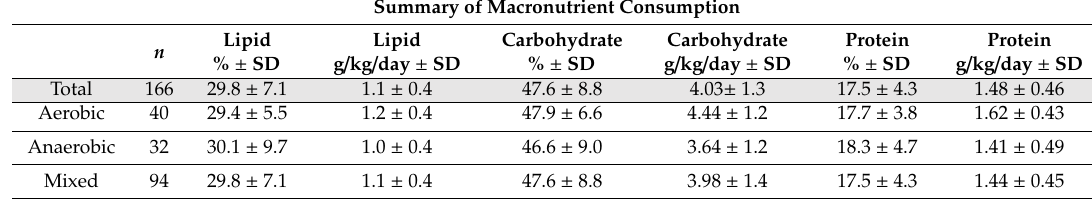
Table 2. Summary of daily macronutrient caloric contribution according to sport type. Macronutrient intake (excluding supplement) is presented both as a percent of the total daily energy intake and as g / kg /